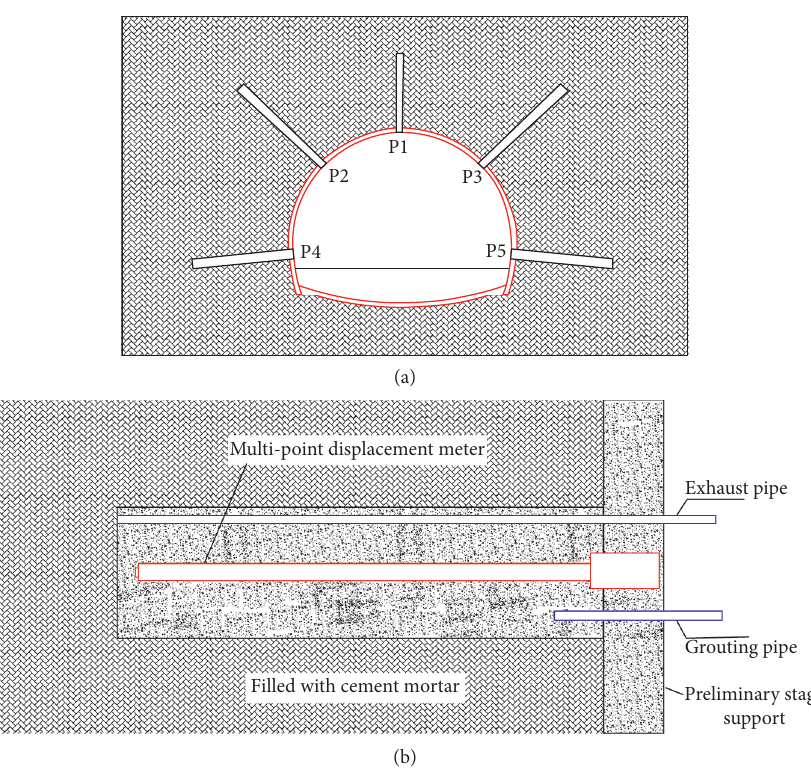
Figure 4: Layout of section measuring points and installation method of multipoint displacement meter. (a) Layout of measuring points, the borehole depth L � 8.0m and aperture Φ 70mm. (b) Multipoint displacement meter installation diagram, the borehole depth L � 8.0–9.0 m and aperture Φ 120mm.